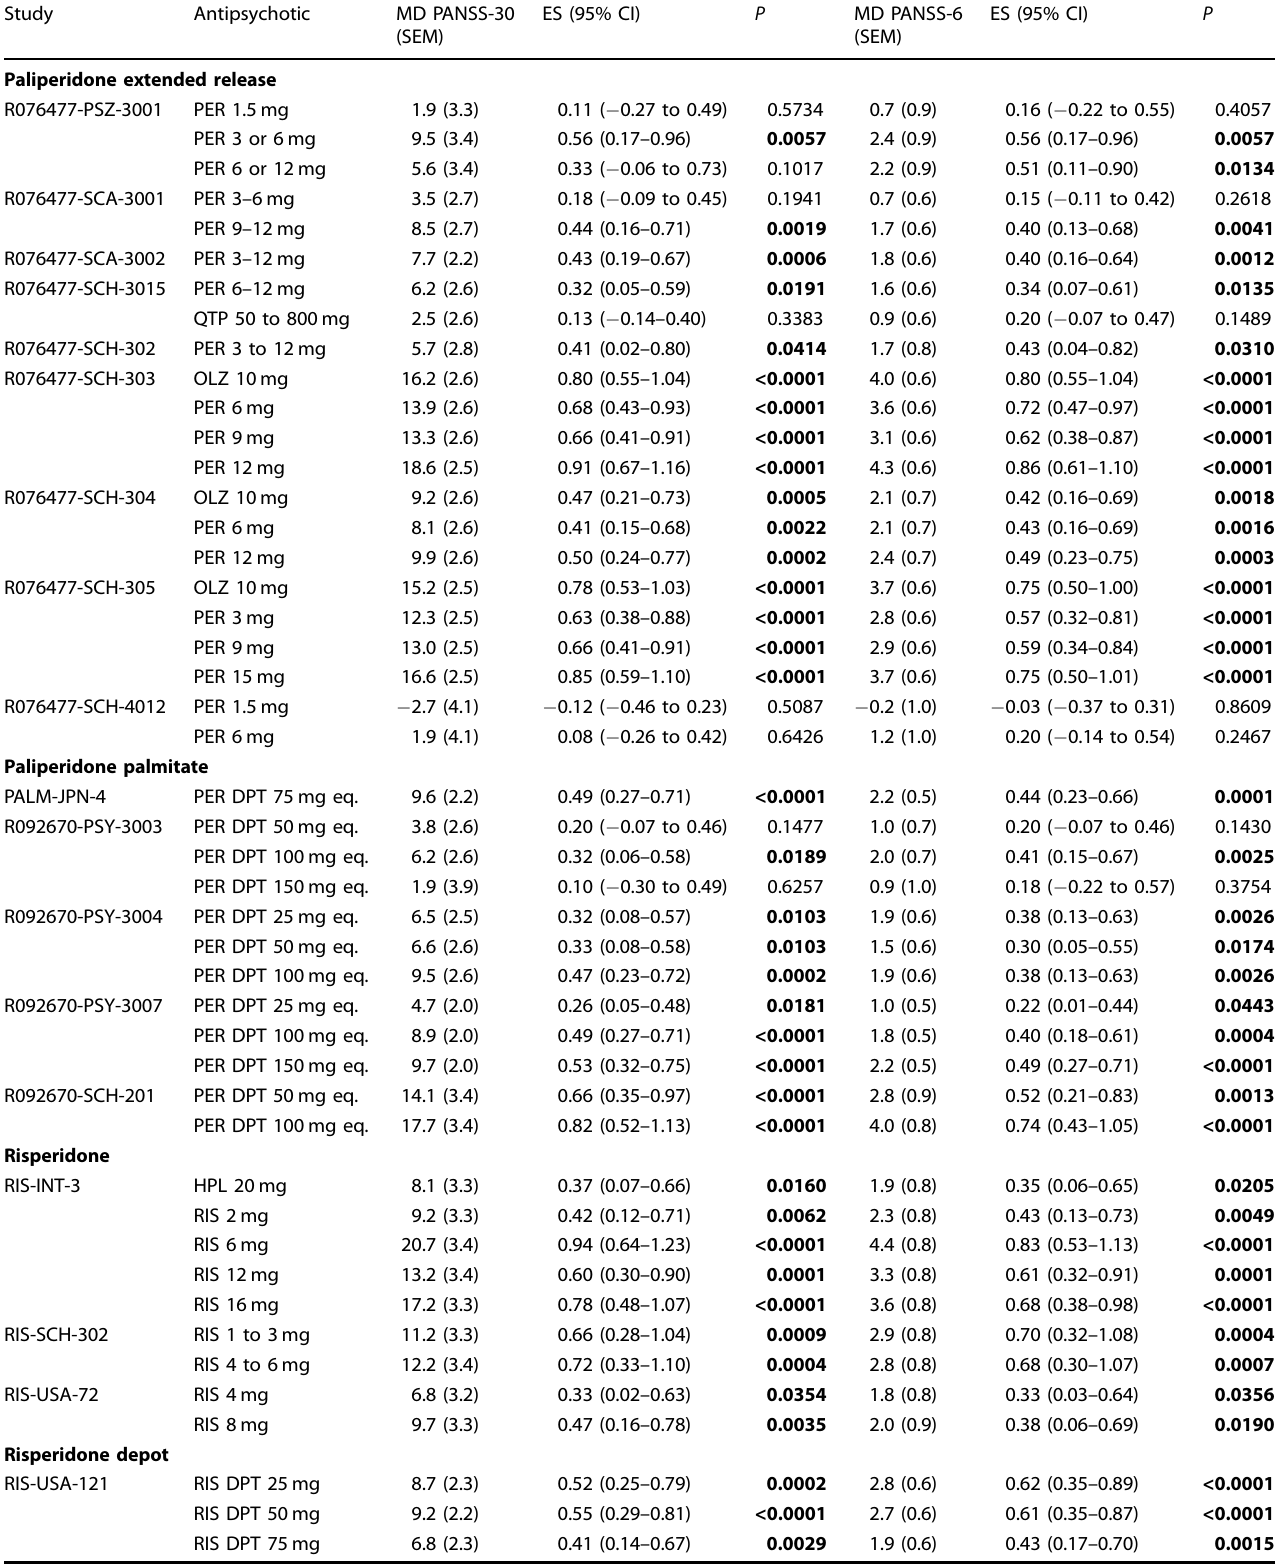
Table 2. Antipsychotic – placebo differences as measured by PANSS-30 and PANSS-6 strati fi ed by study and dose.